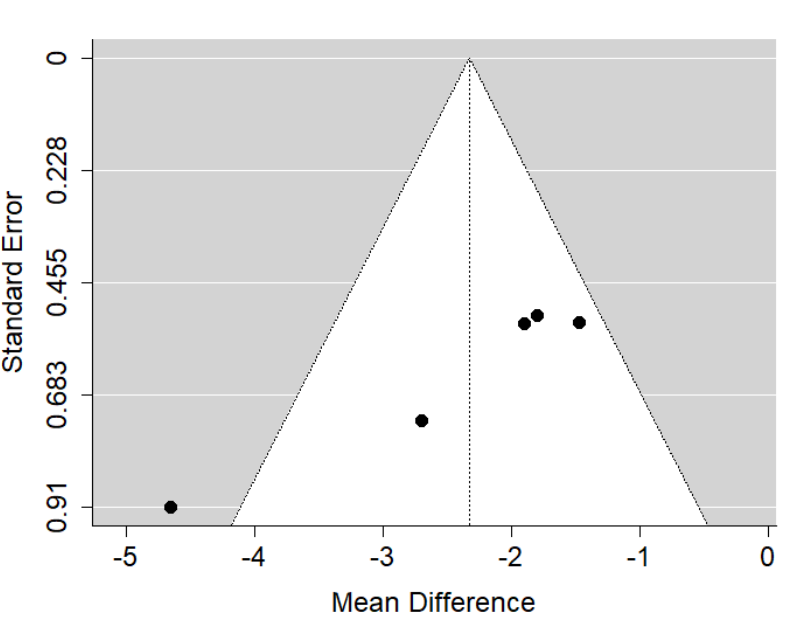
Figure 9. Funnel plot of ANB values for the comparison of patients with untreated cleft palate only vs. non-cleft healthy population [18,34,35].